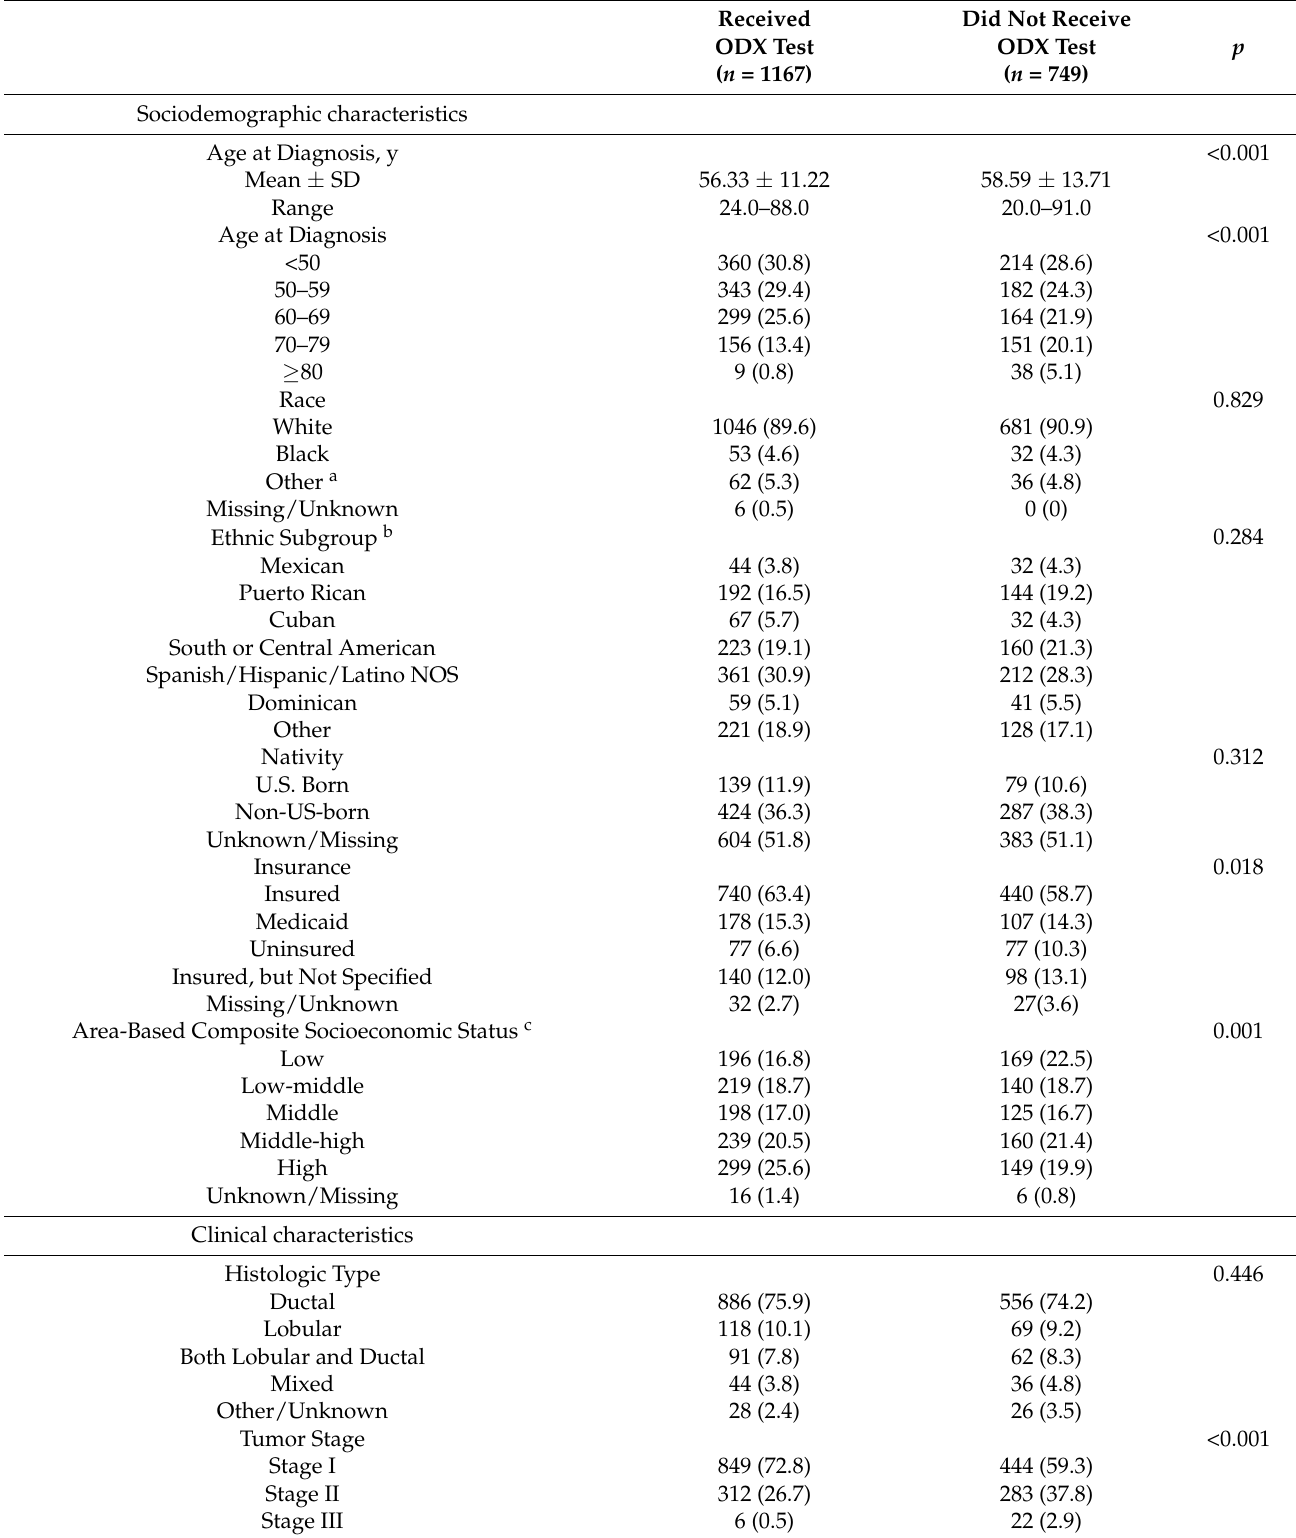
Table 1. Oncotype DX test receipt by demographic characteristics among Latina/Hispanic women diagnosed with breast cancer who were eligible for the test ( n = 1916), New Jersey,